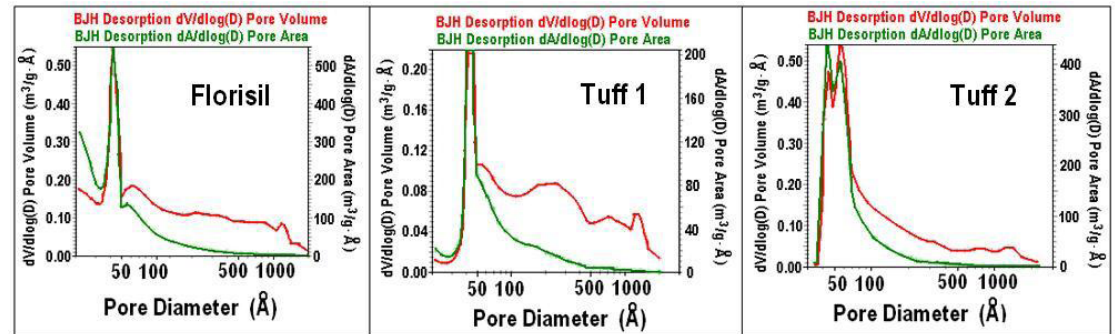
Figure 2. Pore size cumulative /derived distribution curve of the studied catalysts.